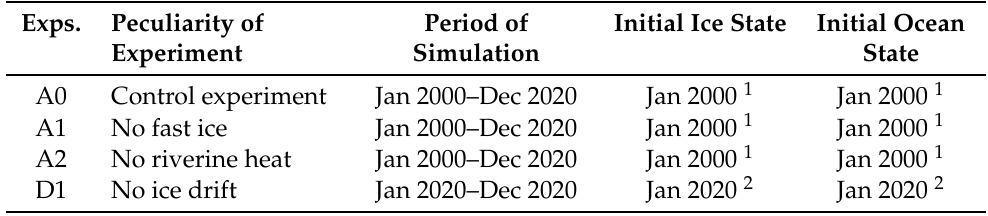
Table 2. Specifications of numerical experiments.